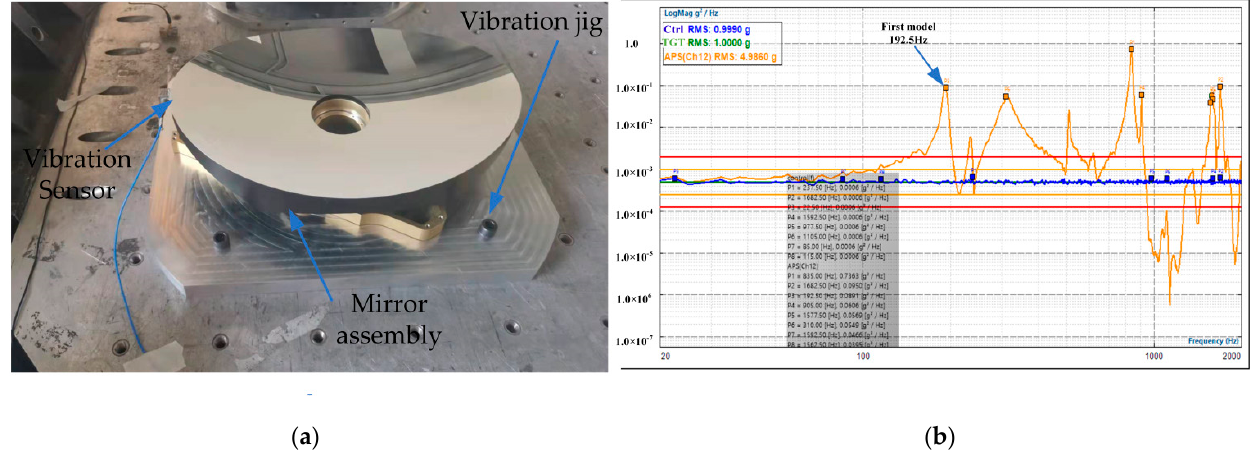
Figure 16. Vibration test of mirror: ( a ) installation of sensor measuring points; ( b ) test results.